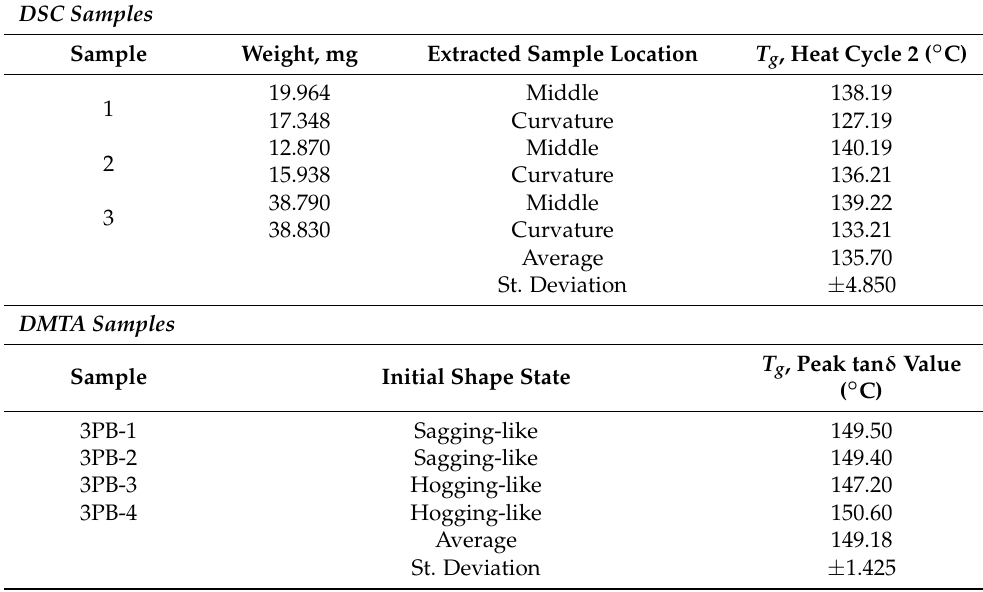
Table 3. DSC and DMTA results: Glass transition temperature ( T g ).